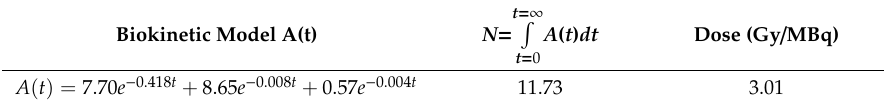
Figure 8. Subcutaneous tumoral model. Intratumoral administration of 177 Lu-DOTA-DN(PTX)-BN after ( a ) 1.5 h, ( b ) 9 h, ( c ) 10 h, ( d ) 24 h, ( e ) 120 h.